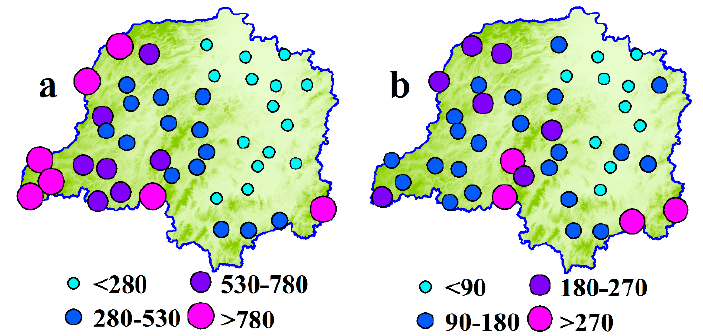
Table 5. Trends for the 5 ‐ year return levels for the four precipitation indices (mm ∙ year − 1 ∙ decade − 1 ). Indices Spring Summer Autumn Winter Indices Spring Summer Autumn